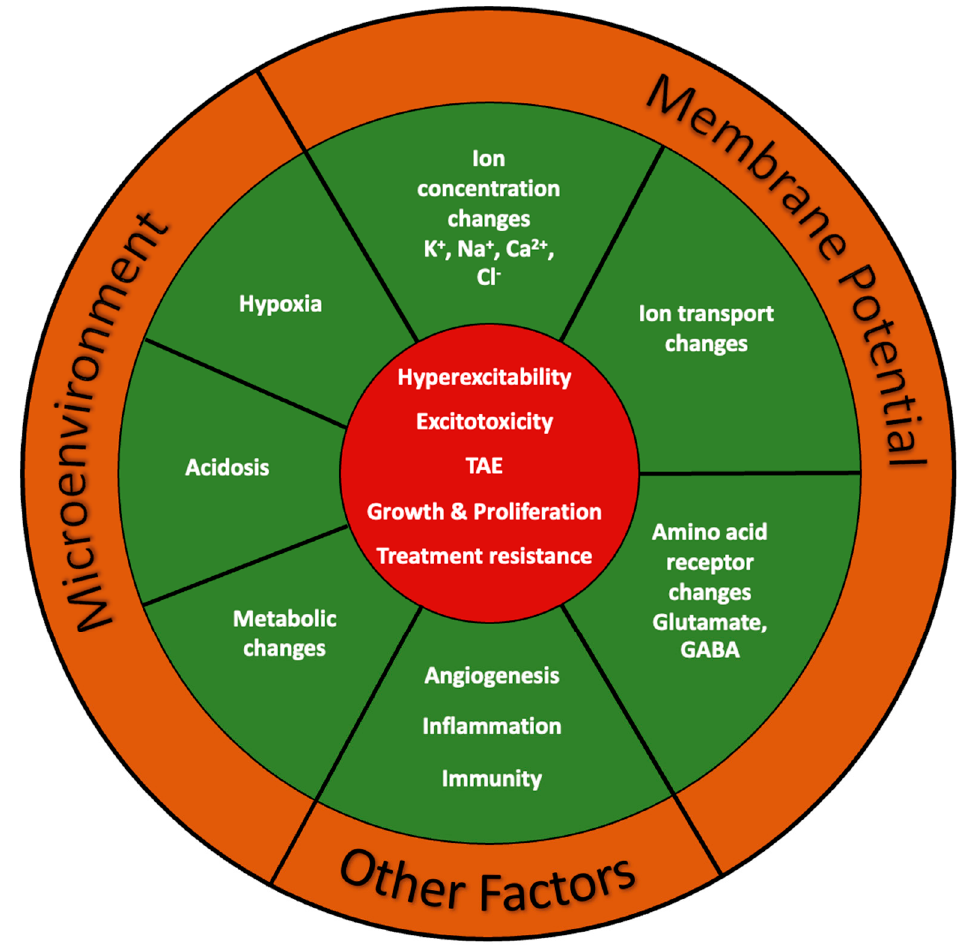
Figure 5. Microenvironment in brain tumors. The interactions between cancer cells and tumor mi- croenvironment (TME) are essential determinants of many hallmarks related to cancer development. TAE, tumor-associated epilepsy.